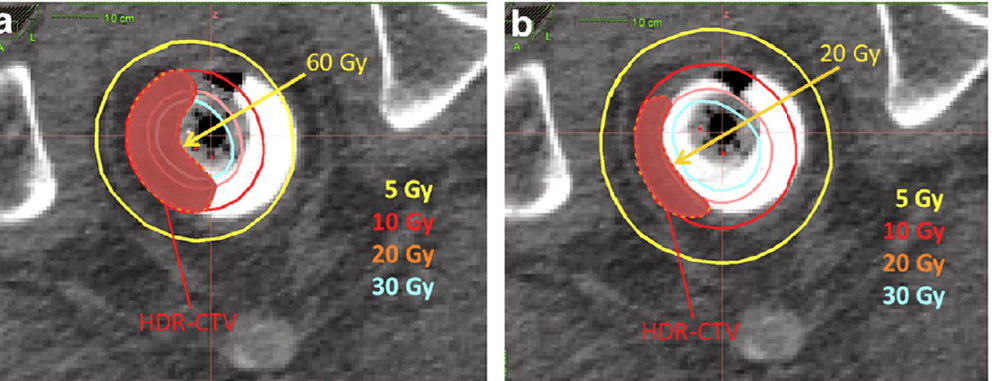
Figure 7. Role of the ipsilateral balloon on lowering the mucosa dose: ( a ) dose distribution without ipsilateral balloon — mucosa receives 60 Gy; ( b ) dose distribution with ipsilateral balloon — mucosa receives 20